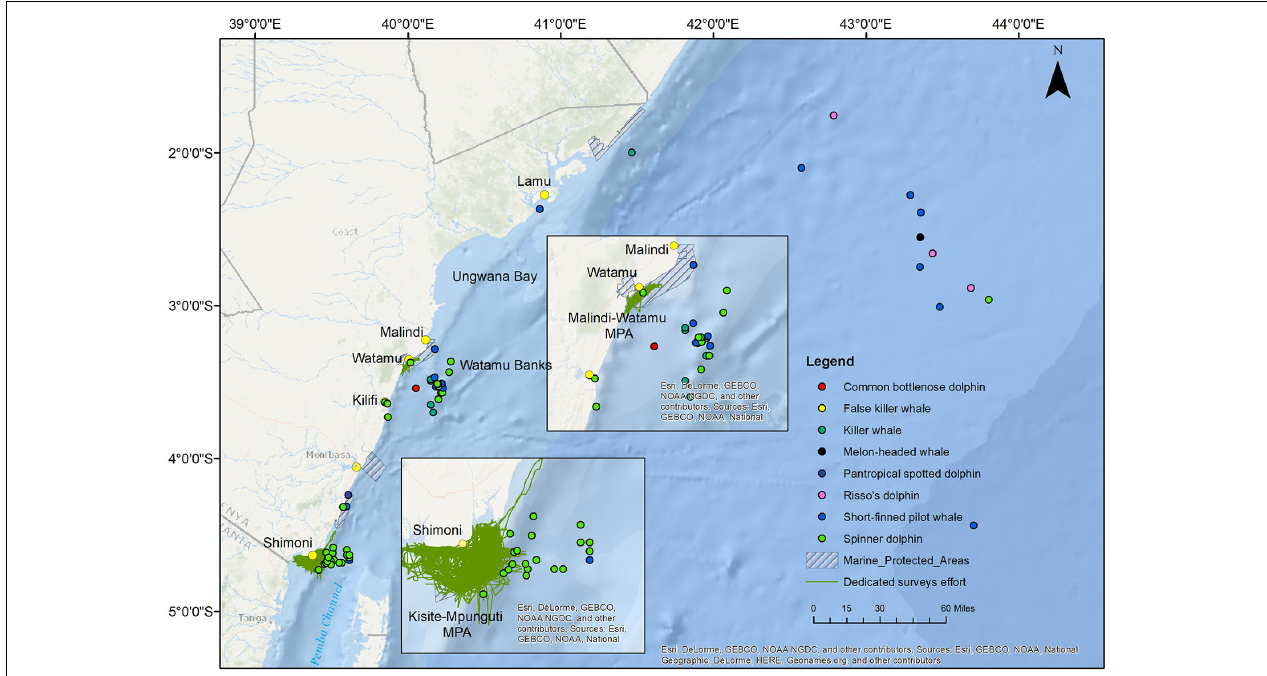
FIGURE 8 | Map showing the distribution of sightings of other small cetacean species sightings along the Kenyan coast. The boxes in the map show the areas with the highest number of reports, waters surrounding Kisite-Mpunguti Marine Protected Area (southern Kenya) and Malindi-Watamu Marine Protected Area (central